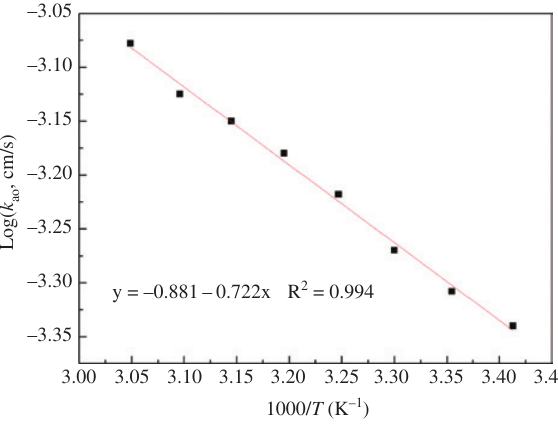
Figure 3: Effect of temperature on mass transfer rate. Aqueous phase: [CeCl [H Cit] = 0.03 mol l −1 ; organic phase: [H 3 stirring speed = 250 rpm.